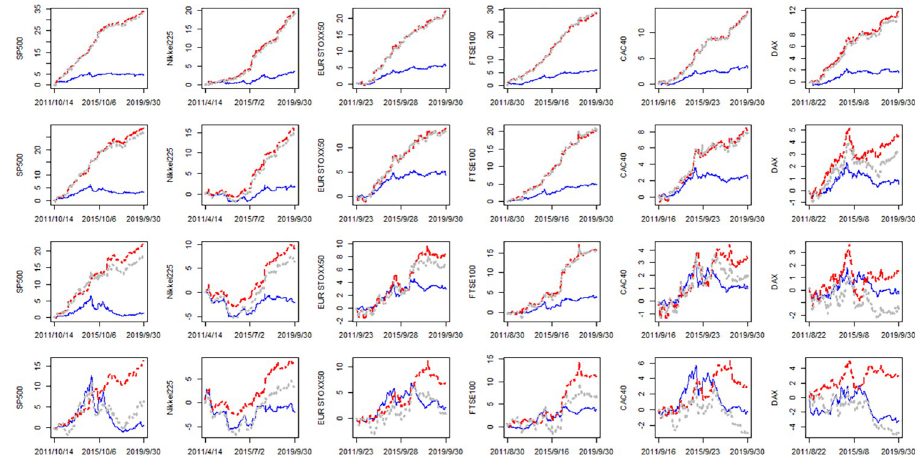
Fig 4. The cumSFE of LHARO, LHARV and LHAROV relative to LHAR (different model setting). Notes: The first, second, third and fourth row corresponding to h = 1,5,10,22, respectively. The blue line, red line and gray line denotes the cumSFE( LHARO , N ), cumSFE( LHARV , N ) and cumSFE( LHAROV , N ), respectively.